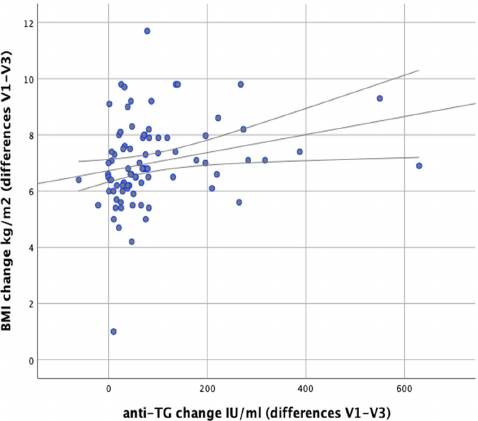
Figure 11. Correlations between differences in BMI and changes in serum anti-TG levels in the women studied (between initial visit V1 and final visit V3).